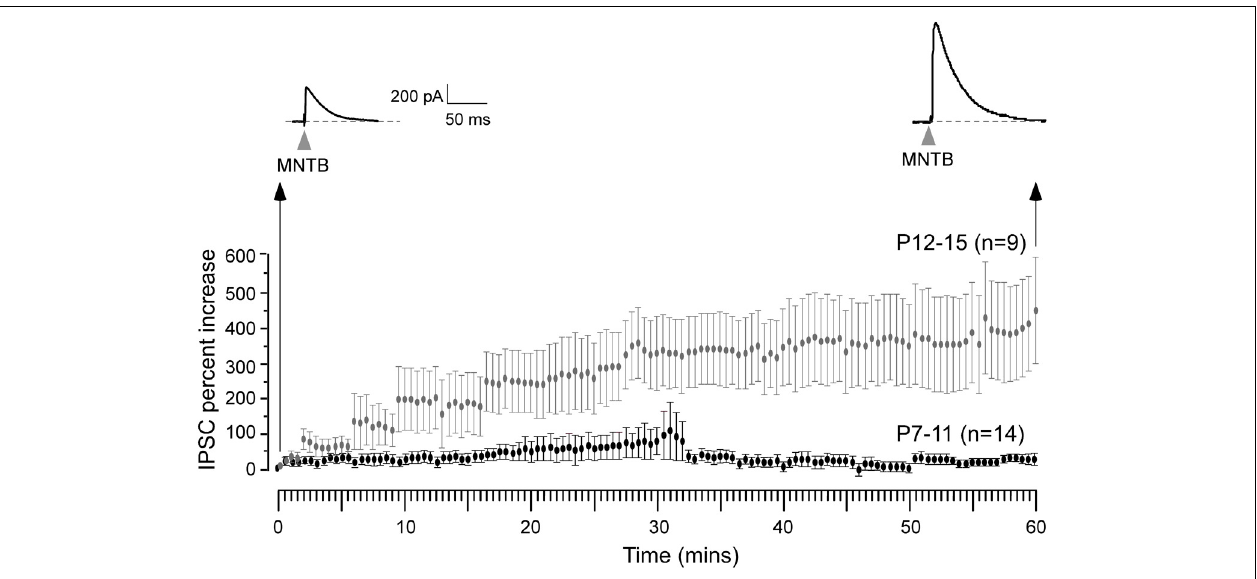
FIGURE 3 | Expression of iLTP is age-dependent. MNTB was continuously stimulated at 0.033Hz for 1h while voltage clamp recordings were obtained from the LSO neurons in the presence of ionotropic glutamate receptor antagonist kynuranic acid at V HOLD = 0mV. Under these circumstances, IPSCs were recorded as outward